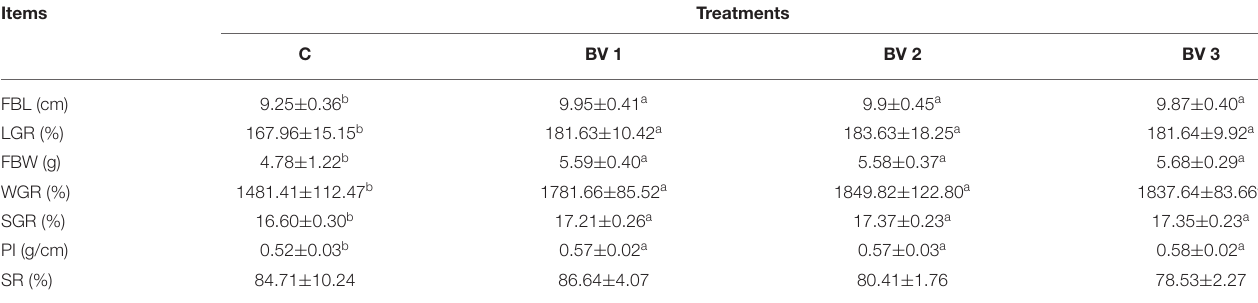
TABLE 2 | Effects of different supplementation levels of B. velezensis BV007 on the growth performance and survival of L. vannamei